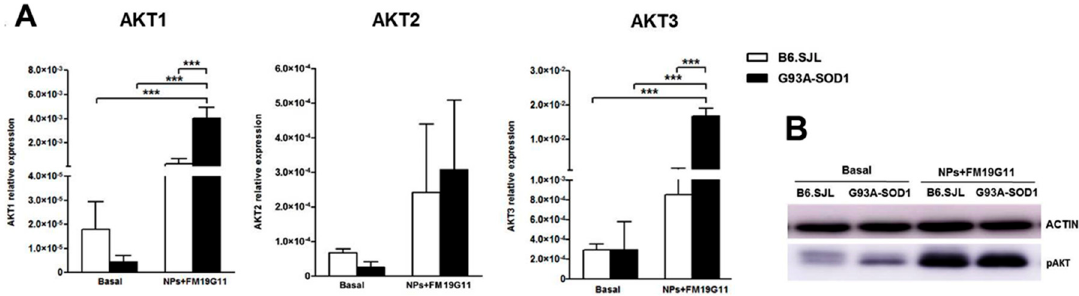
Figure 3. Analysis of AKT1-3 expression following FM19G11-loaded NP treatment ( A ) qRT PCR expression analysis of the AKT1 , AKT2 , and AKT3 genes in 12-week B6.SJL (white bars) and G93A-SOD1 (black bars) epSPCs after 48 h of FM19G11-loaded NP treatment compared to basal conditions. Expression levels reported as mean ± SD of 2 −Δ CT values normalized against the endogenous control 18S ( n = 5 different primary cell cultures from five animals per group). ( B ) Representative Western blot analysis of p-AKT and β -actin ( n = 2 different primary cell cultures from two animals per group). *** p < 0.001 by ANOVA followed by Bonferroni post-hoc test.